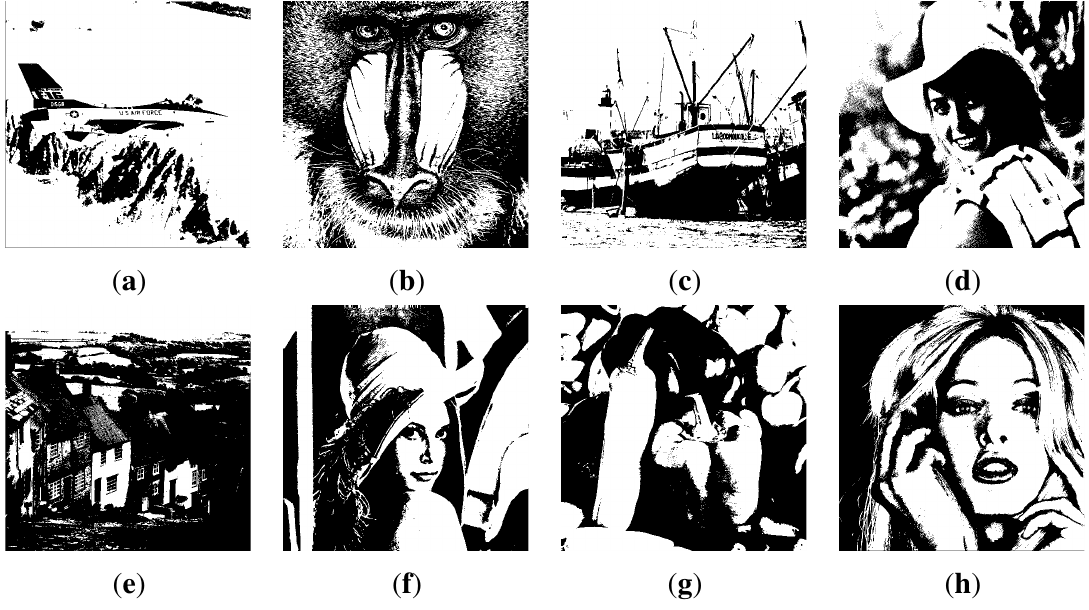
Figure 4. Eight binary images. ( a ) F16; ( b ) baboon; ( c ) boat; ( d ) Elaine; ( e ) Gold Hill; ( f ) Lena; ( g ) pepper; ( h ) Tiffany.